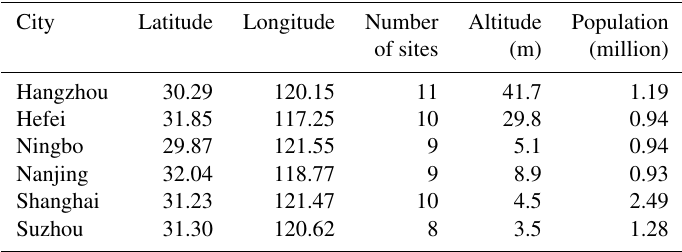
Table 1. Geolocation, the number of measurement sites, and population for the six megacities within the YRD. Population statistics are based on the seventh nationwide population census in 2020 provided by the National Bureau of Statistics of China.